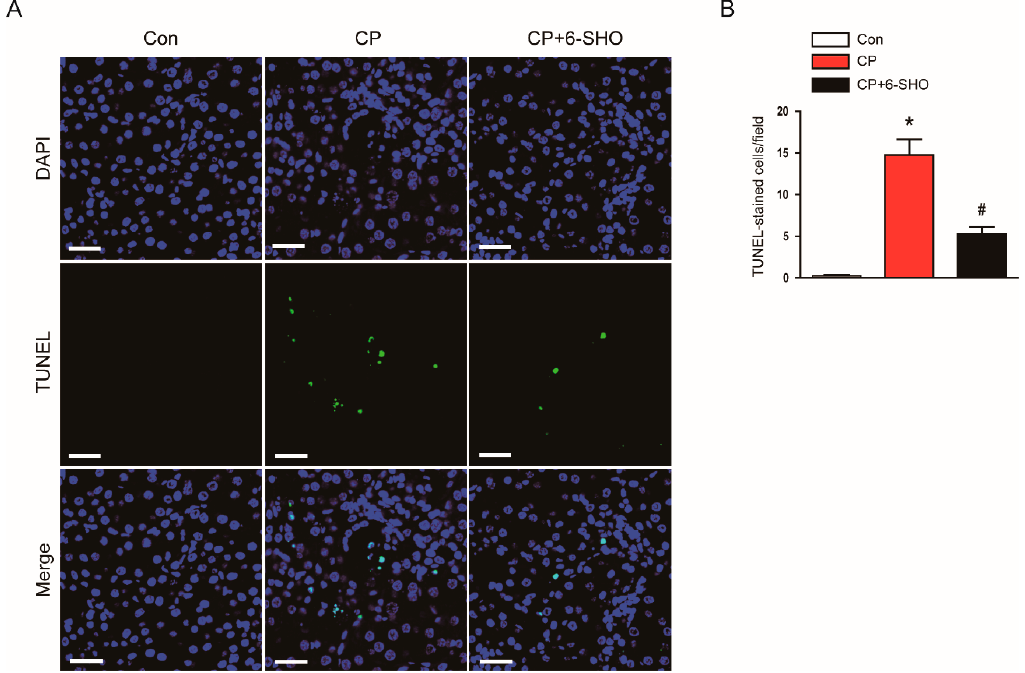
Figure 6. Effect of 6-shogaol on tubular cell apoptosis in cisplatin-treated mice. ( A ) TdT-mediated dUTP nick end labeling (TUNEL) assay on kidney sections. Scale bar = 10 μ m. To detect nuclei, 4 ′ , 6-diamidino-2-phenylindole (DAPI) was used. ( B ) Number of TUNEL-stained cells per field. n = 8 per group of mice. * p < 0.05 versus Con. # p < 0.05 versus CP.